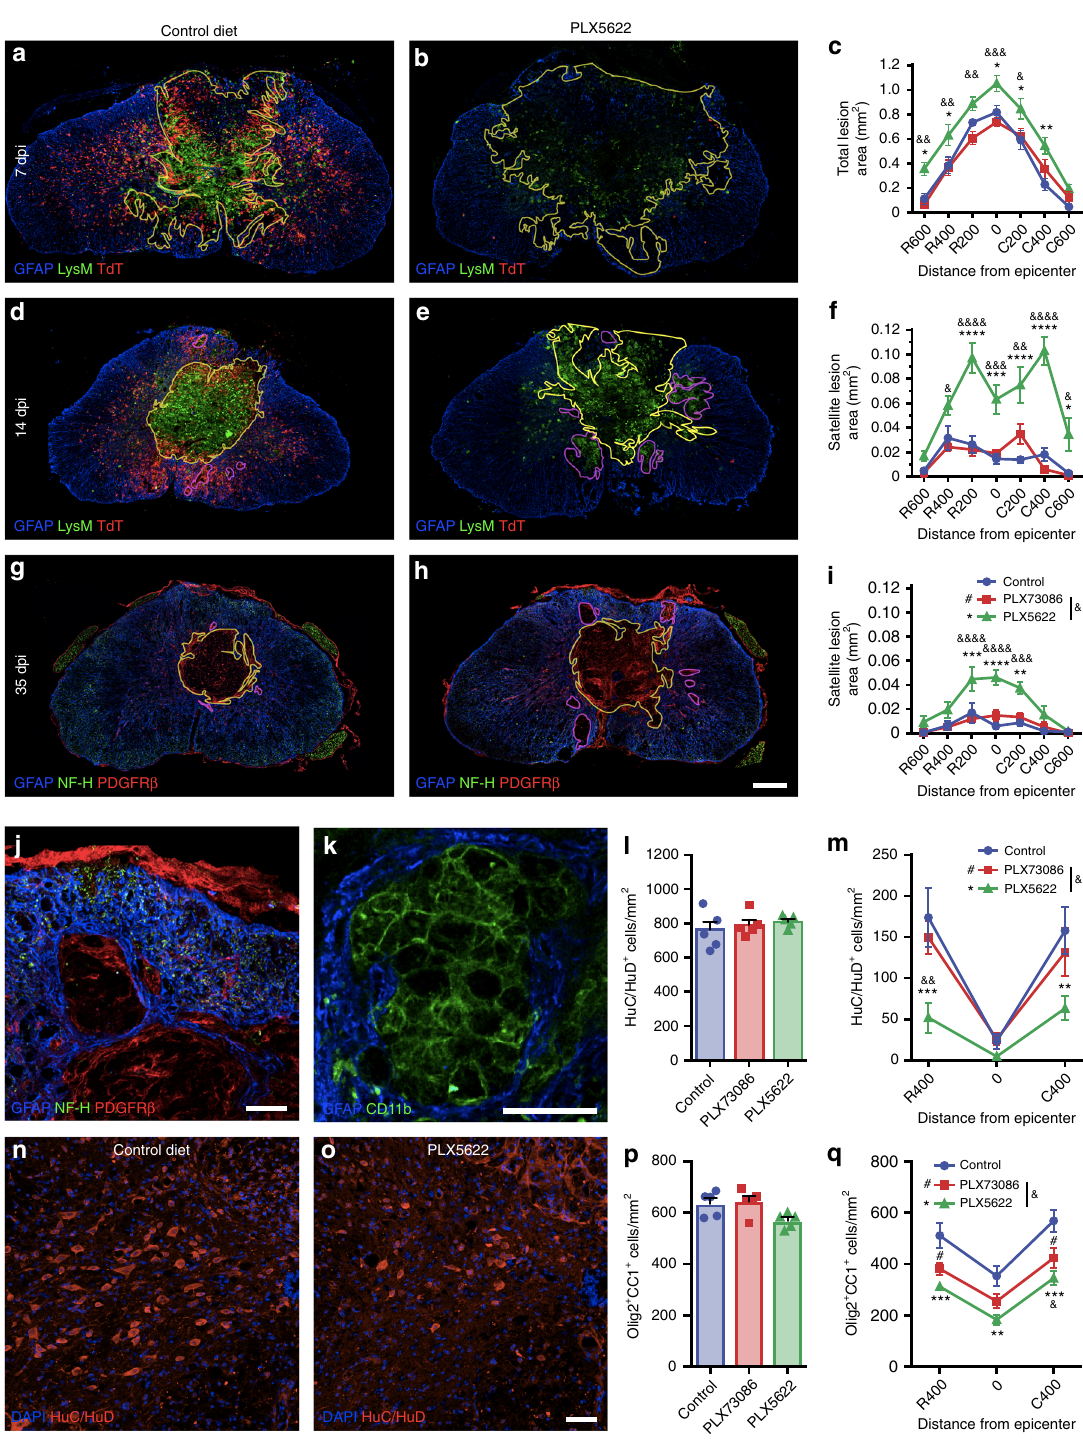
an increased loss of neurons and oligodendrocytes at the site of SCI, as well as greater tissue damage and impairment in locomotor function. The comparison of two CSF1R inhibitors with different BSCB permeability (given at various times before and after SCI) provided strong evidence that the protective function of microglia takes place during the fi rst week post-SCI, matching the peak of proliferation of microglia. Accordingly, local delivery of the microglial proliferation factor, M-CSF, at the site of contusion